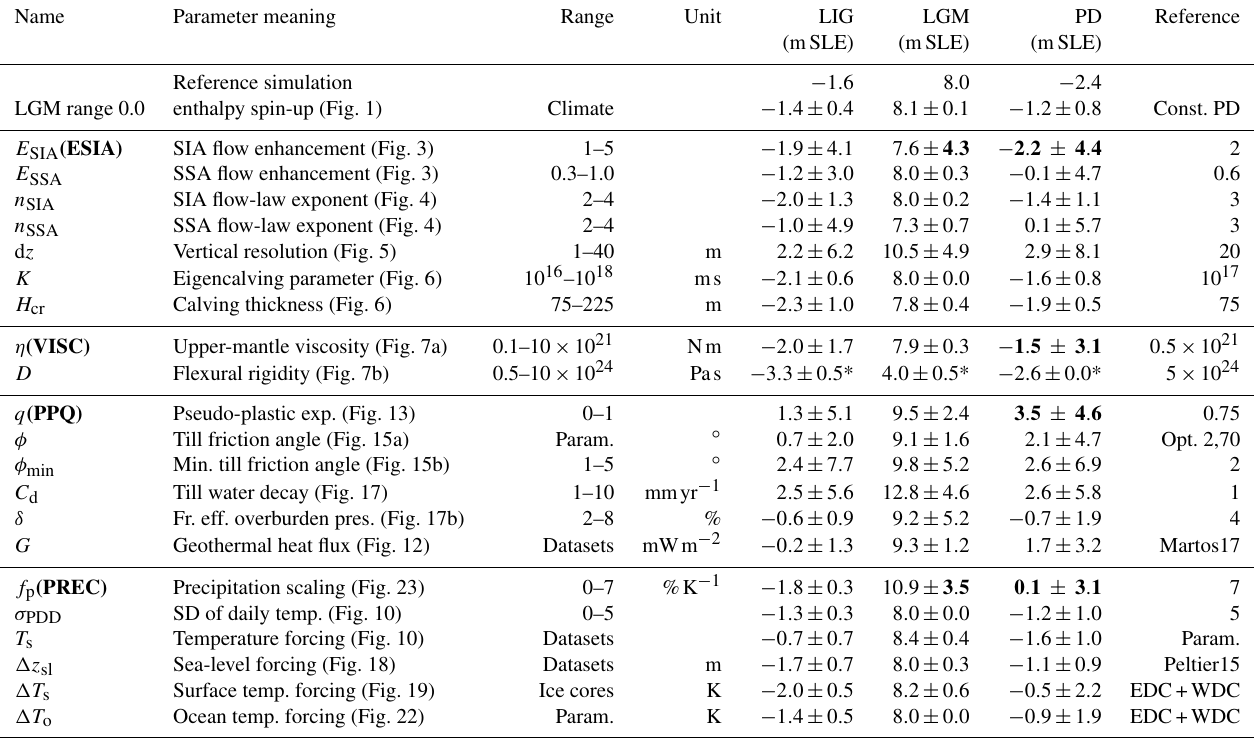
Table 2. Sensitivity (mean and standard deviation) of simulated ice volume at Last Interglacial (LIG), Last Glacial Maximum (LGM) and present day (PD) for varied input datasets and model parameters (some of which are already indicated in Table 1), and the used reference value. Selected ensemble parameters for each category are bold: VISC and PPQ are more relevant to deglacial and present WAIS dynamics, and ESIA and PREC are relevant rather to EAIS dynamics. Asterisk indicates a different PISM version